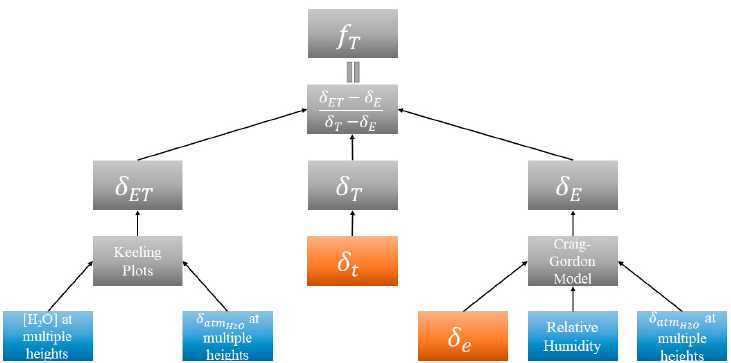
Figure 2. Conceptual diagram for obtaining f T using the stable isotope method. All δ values represent either δ 2 H or δ 18 O. Blue boxes represent 30 min National Ecological Observatory Network’s (NEON) data, orange boxes represent monthly samples. δ e = isotopic composition of soil water at evaporating front, obtained from soil samples and δ t = isotopic composition of xylem water, obtained from twig samples collected under steady-state